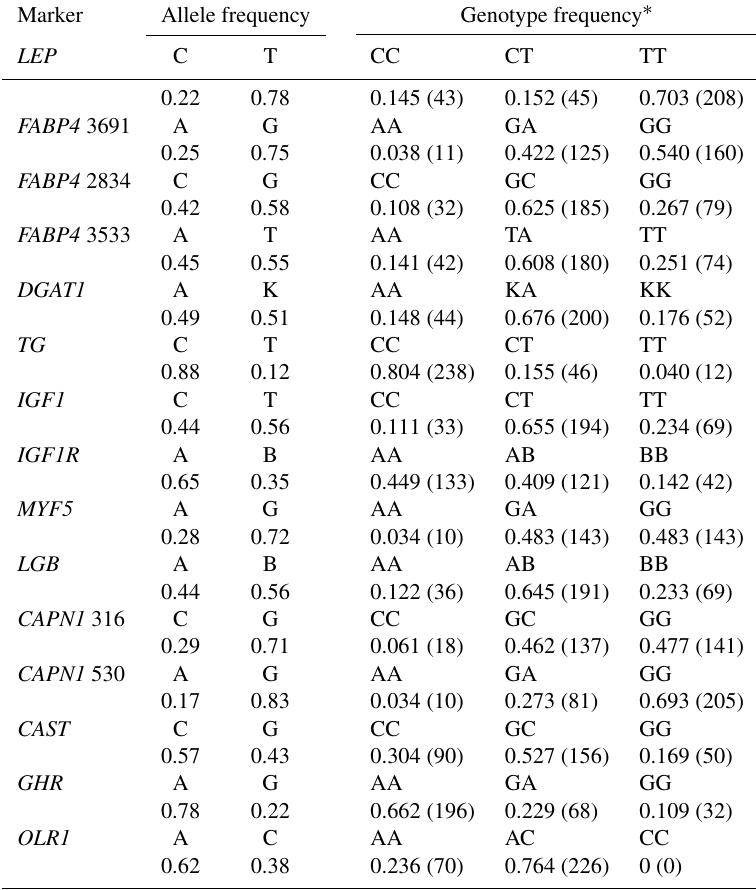
Table 2. Allele and genotype frequencies for the 15 markers in the total sample of animals ( n = 296).